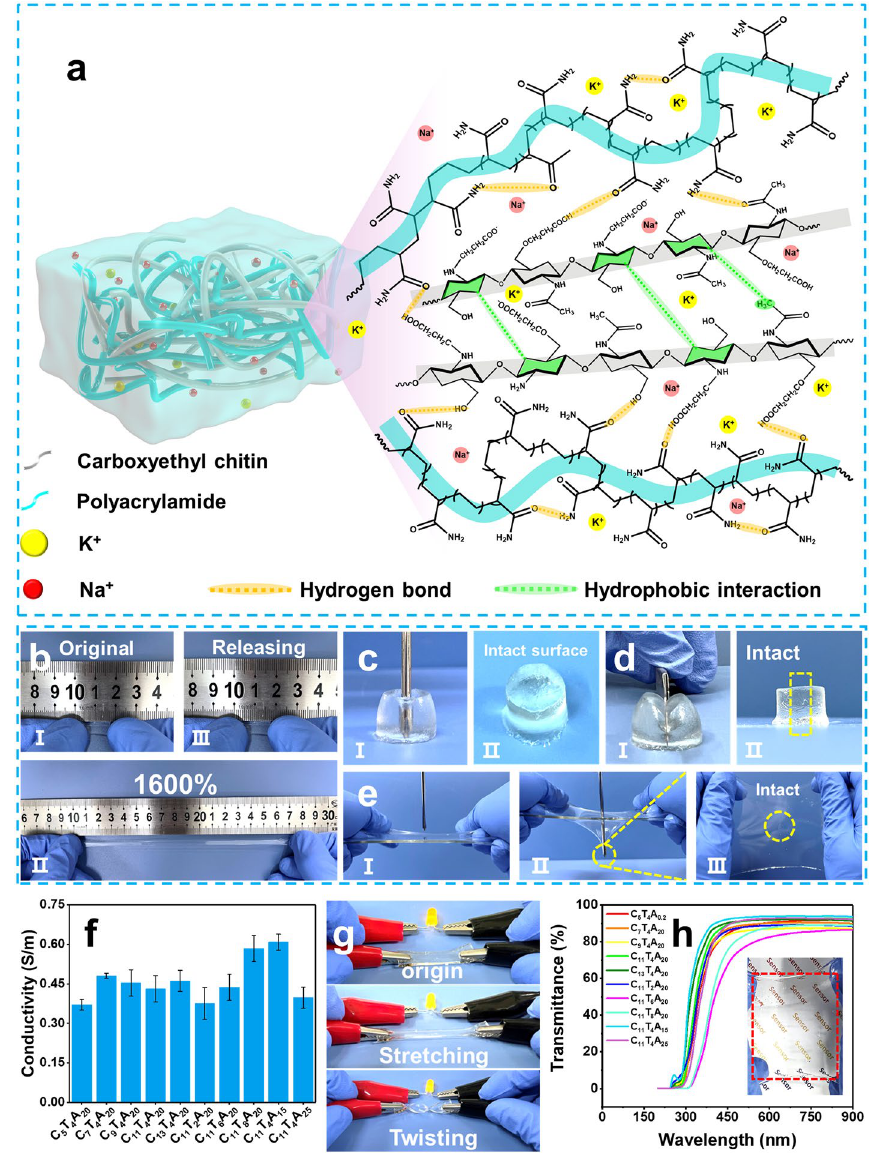
Fig. 1 a Schematic illustration and molecular interaction among CECT, PAAm in the CTA hydrogel. b Photographs of the CTA hydrogel pre- senting neglectable residual strain without breaking even after being stretched to 1600% strain. c Photographs of poking a cylindrical CTA hydrogel with a sharp cross screwdriver. d Photographs of cutting a 1.8-cm-thick CTA hydrogel from top to bottom with a sharp blade. e Pho- tographs of poking a stretched CTA hydrogel film with a sharp cross screwdriver. f Conductivity of the CTA hydrogels with different contents. g Luminance variations of LEDs using C 11 T 4 A 20 hydrogel as a conductor which is subjected to stretching of 200% strain and twisting. h Trans- mittance of the CTA hydrogel with a thickness of 2 mm in the visible wavelength range of 400−900 nm. Inset is a photograph of a transparent C 11 T 4 A 20